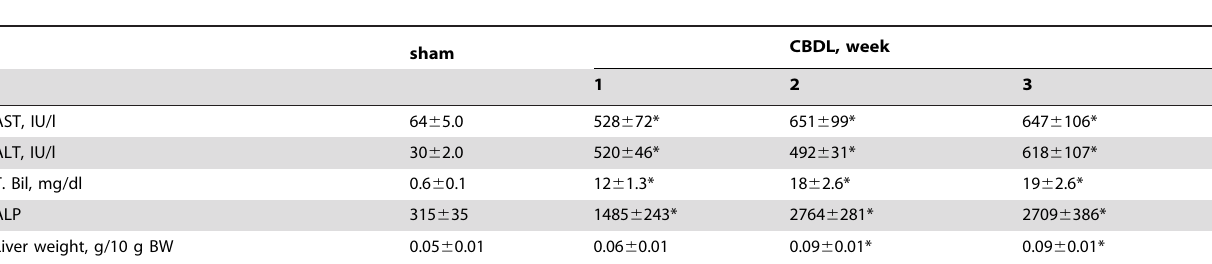
Table 2. Laboratory data after common bile duct ligation in mice.